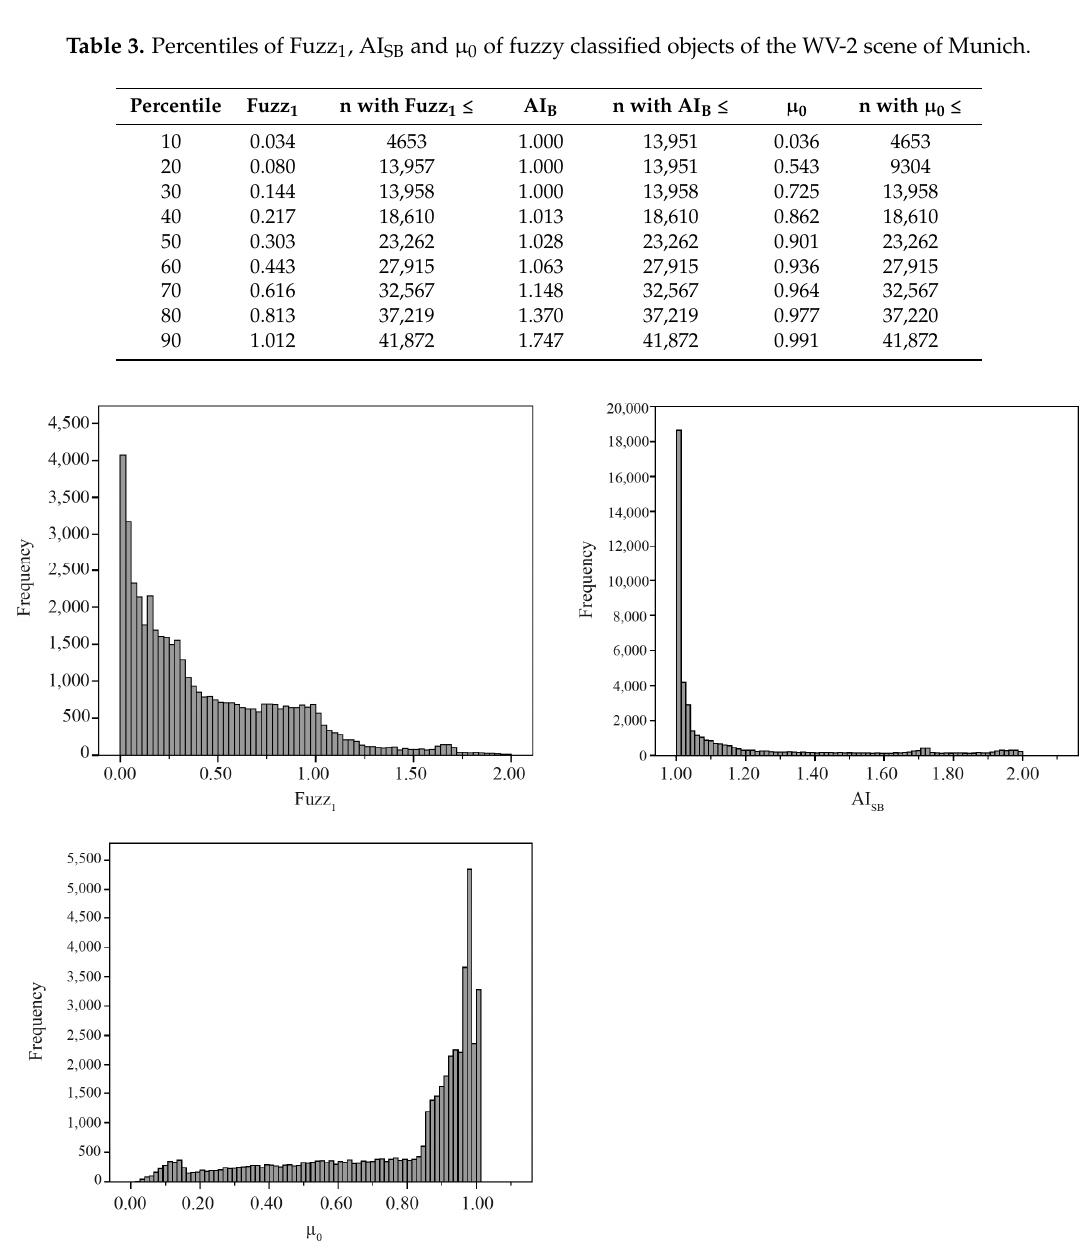
Figure 8. Histograms of Fuzz (cid:2869) , AI (cid:2903)(cid:2886) and μ (cid:2868) of fuzzy classified objects of the WV-2 scene of Munich.